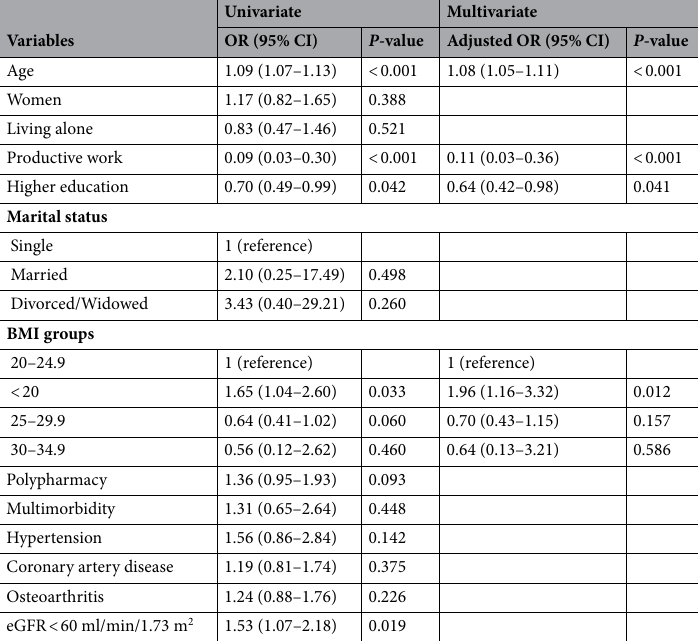
Table 4. Factors associated with frailty in the logistic regression analysis (n = 638). Variables that had a P -value < 0.2 in the univariate regression were included in the multiple regression. Only variables that had a P -value < 0.05 in the multiple regression are shown. eGFR estimated glomerular filtration rate, BMI body mass index, CI confidence interval, OR odds ratio.